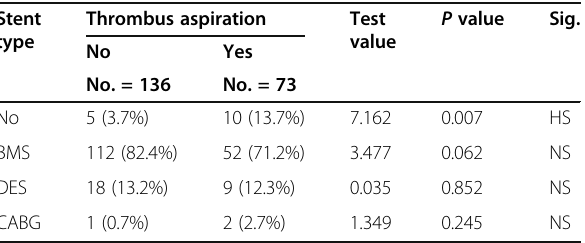
Table 3 Comparison between the 2 groups regarding intervention, the number of stent needed in